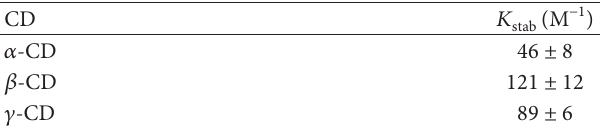
Table 3: 𝐾 stab values calculated from phase-solubility studies for the CDs